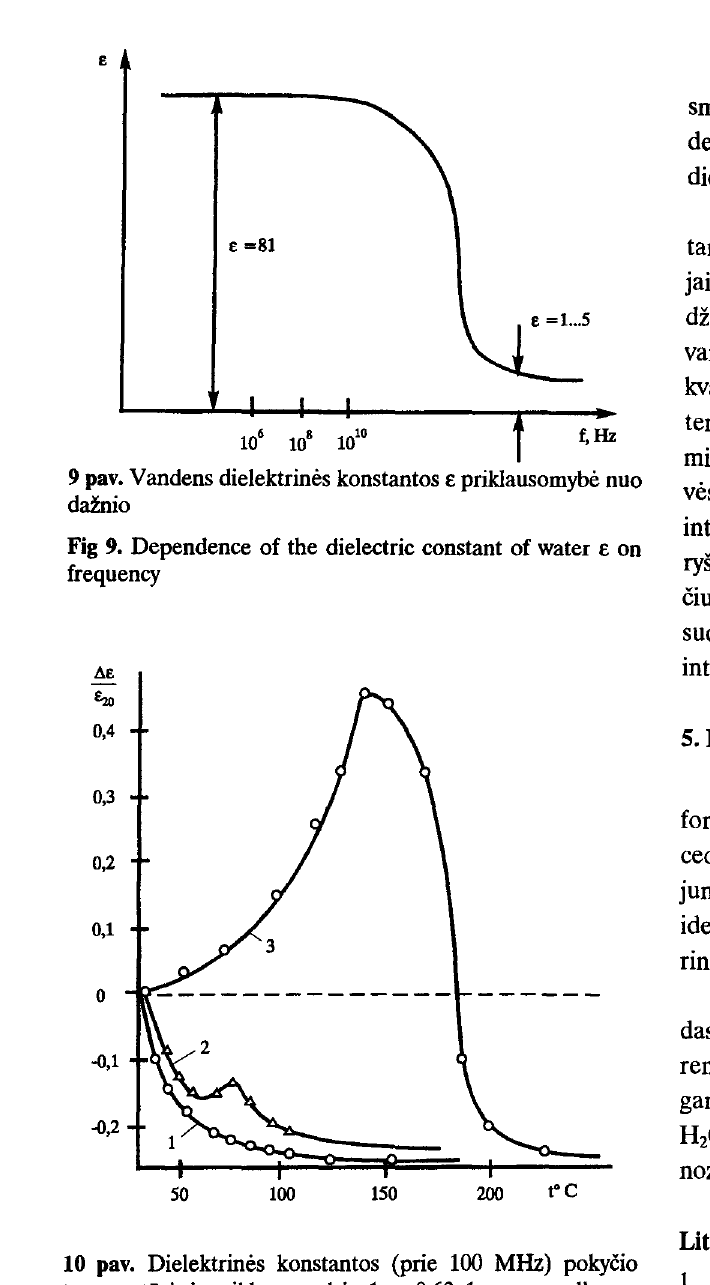
Fig 10. Dependence of dielectric constant on temperature 1- 0,63 ... 1 mm quartz, 2- Quartz powder original area 450 m 2 /kg, 3- Amorphous